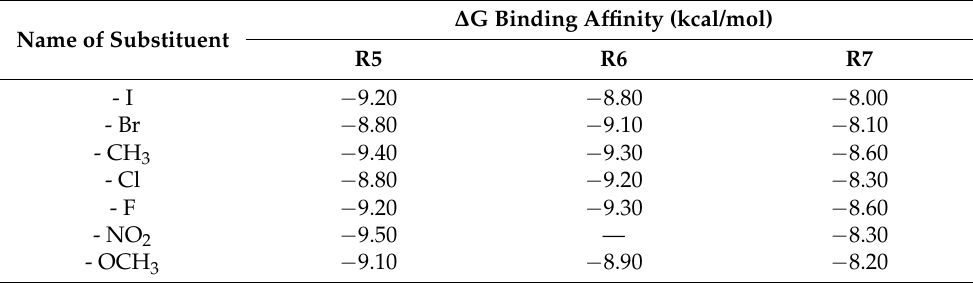
Table 1. The values of binding affinity ( ∆ G) of substituted isatin derivatives towards CDK2 active site. The reference value obtained for non-substituted isatin derivative is − 8.9 (kcal/mol). ∆ G Binding Affinity (kcal/mol) Name of Substituent